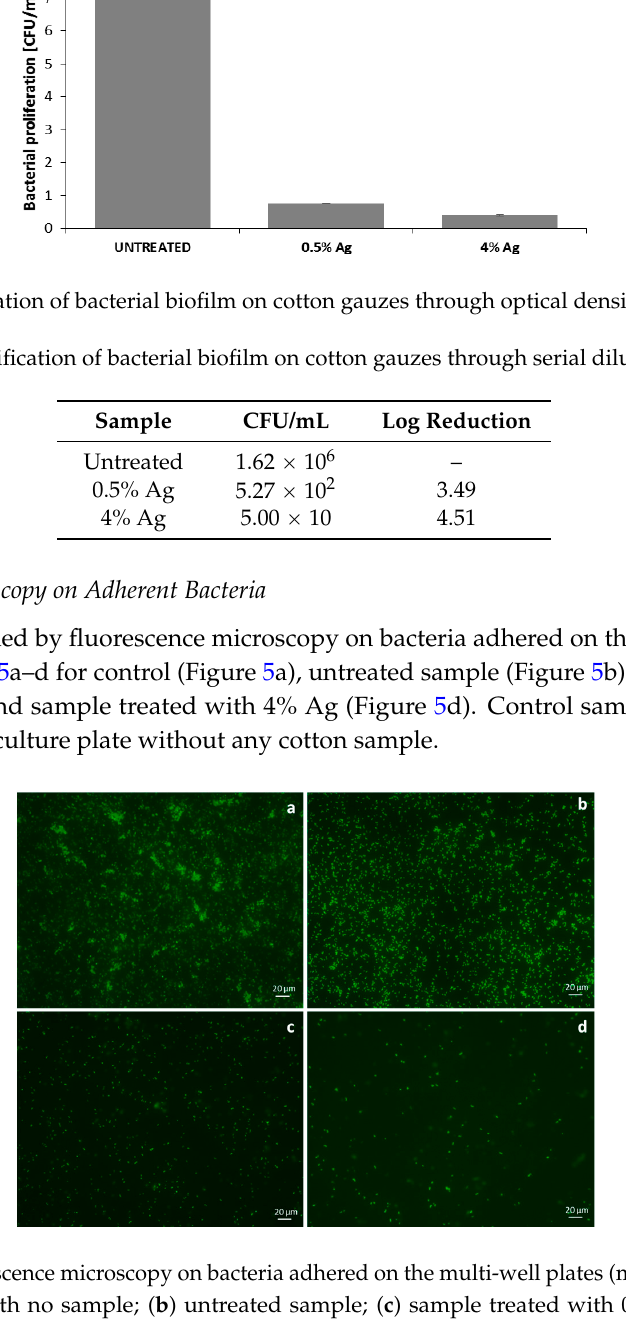
Figure 5. ( a ) Fluorescence microscopy on bacteria adhered on the multi-well plates (magnification ×40) after incubation with no sample; ( b ) untreated sample; ( c ) sample treated with 0.5 wt/v % silver; ( d ) sample treated with 4 wt/v %